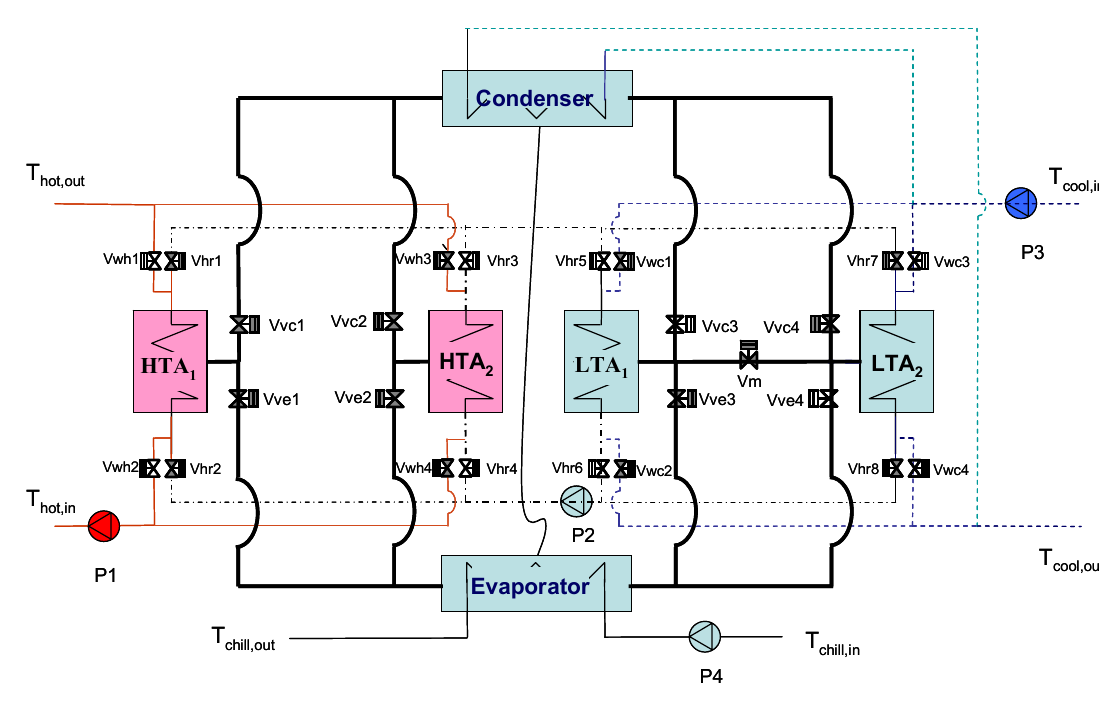
Figure 3. Schematic diagram of a four bed cascading